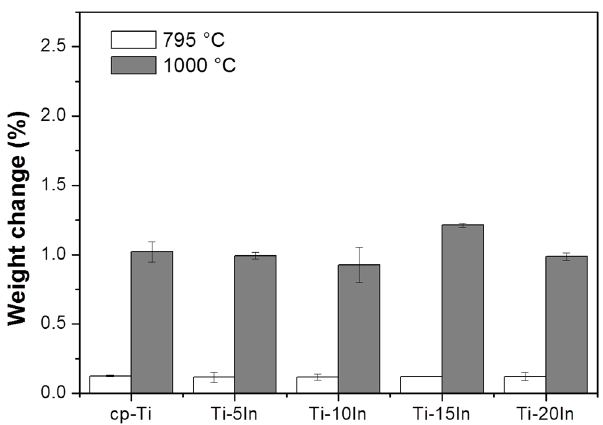
Figure 8. Thermogravimetric analysis (TGA) of cp-Ti and Ti- x In alloys showing various degrees of weight gain (%) after heating in air up to 795 °C and 1000